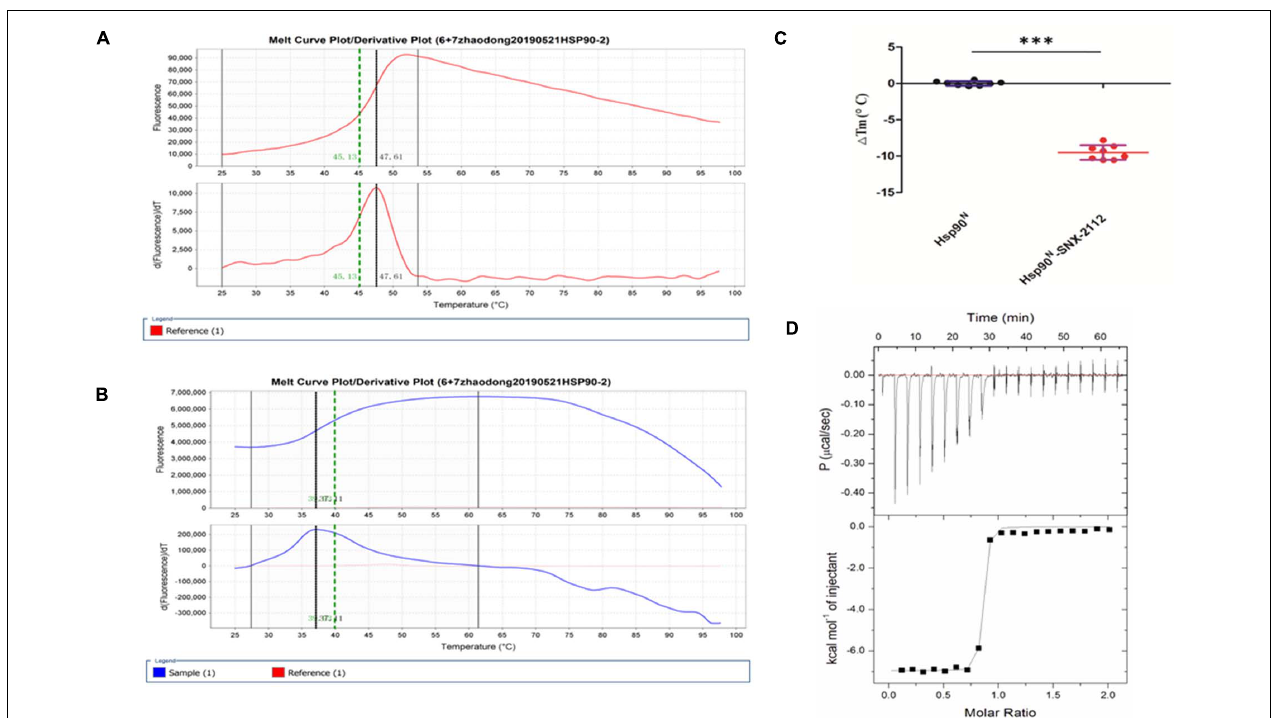
FIGURE 4 | Molecular interaction analysis performed by thermal shift assay (TSA) and isothermal titration calorimetry (ITC). (A) Melting curve of Hsp90 N . (B) Melting curve of SNX-2112 binding with Hsp90 N . (C) (cid:49) Tm ( ◦ C) value of SNX-2112 binding with Hsp90 N ( − 9.51 ± 1.00 ◦ C, *** p < 0.001 vs. control, Hsp90 N , n = 8). (D) ITC plots for the ligand SNX-2112 binding with its target Hsp90 N . The upper panel manifests the raw titration data. The power was supplied to the system to maintain a constant temperature against time (the area of each peak gives the heat of interaction for that injection). The lower panel exhibits the bimolecular fit of the normalized heats of interaction plotted against the molar concentration. Titrations were performed at 25 ◦ C in PBS (pH 7.5, 20 mM Tris–HCl, 150 mM NaCl). The values were presented as mean ± SD. The result indicated an intense binding force and favorable thermodynamic changes during the Hsp90 N -SNX-2112 binding process.